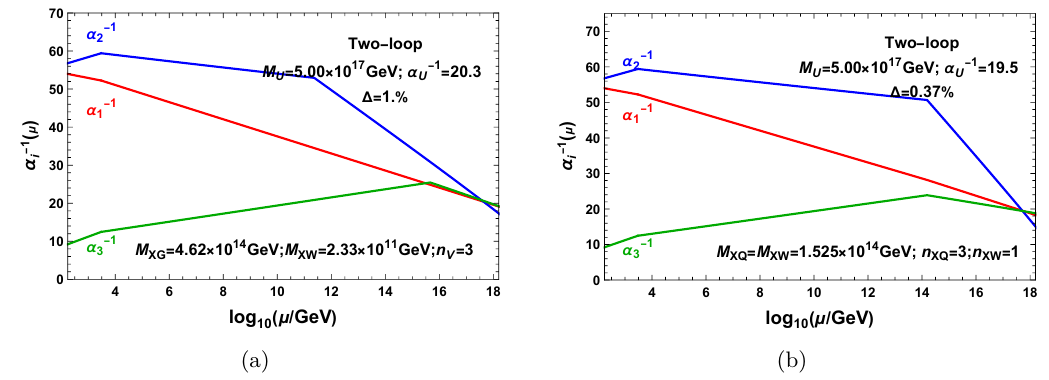
Figure 7 . Two-loop evolution of gauge couplings for the Model 14 with vector-like particles. In the model, k = 35 × 5 and k = 35 . The string-scale gauge coupling relation can be achieved by Y 2 32 3 66 adding 3( XW + XG ) (a) and 3( XQ + XQ ) + XW (b).